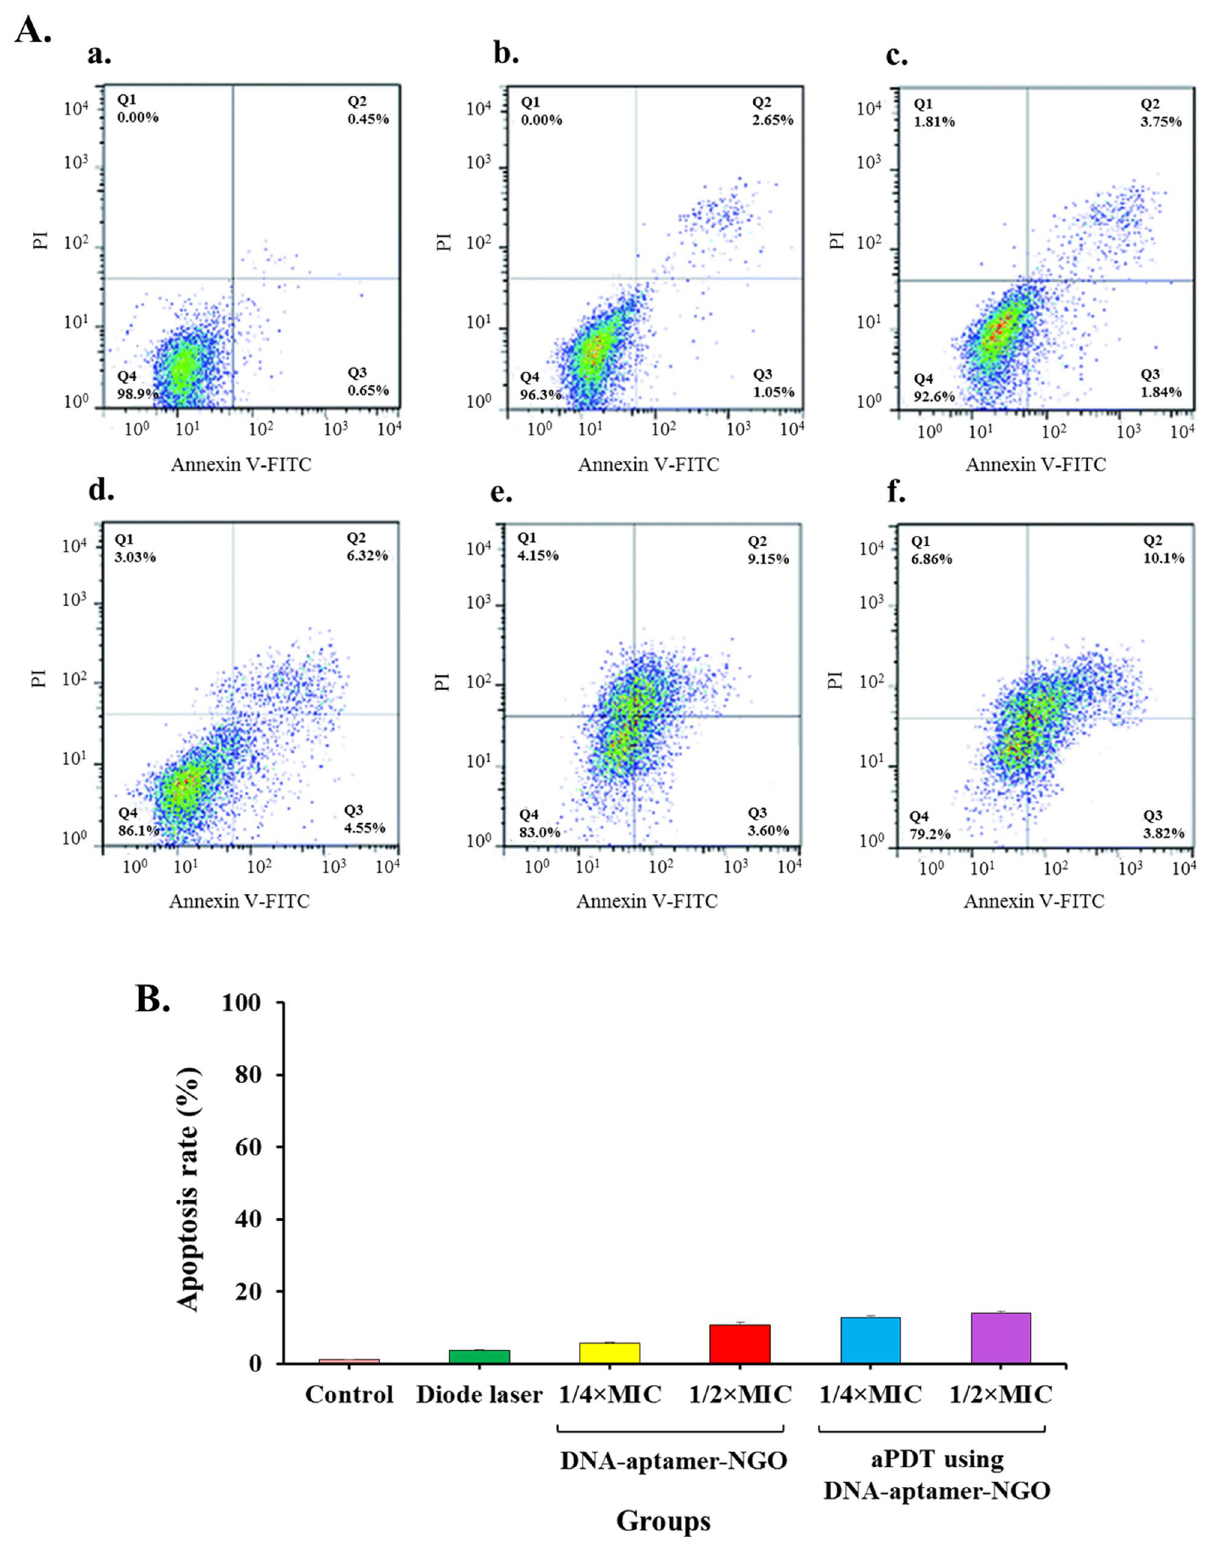
Figure 14. Determination of the apoptotic effects in treated human gingival fibroblast cells with different treatment groups: ( A ) The apoptotic ratio was assessed by flow cytometry with Annexin-V/-FITC/PI staining in human gingival fibroblast cells: (a) control (untreated cells), (b) diode laser, (c) 1/4 × MIC of DNA-aptamer- NGO, (d) 1/2 × MIC of DNA-aptamer-NGO, (e) aPDT using 1/4 × MIC of DNA-aptamer-NGO plus diode laser, and f. aPDT using 1/2 × MIC of DNA-aptamer-NGO plus diode laser; ( B ) Percent of cell viability at 540